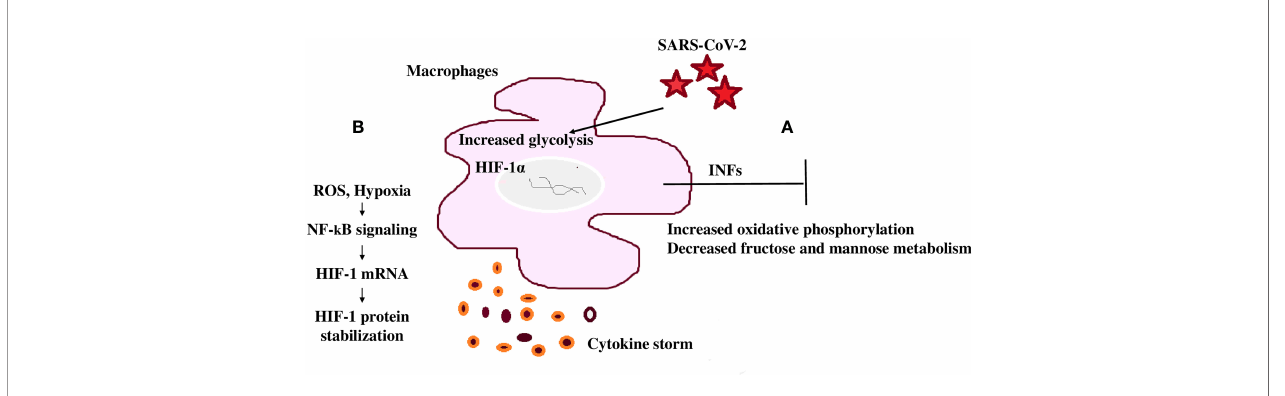
FIGURE 4 | SARS-CoV-2 mediated immunomodulation contribution to mortality (A) COVID-19 patients share a common immunomodulatory failure to induce signi fi cant type I IFN responses in whole blood or PBMCs. This happens in concurrence with other modulated metabolic pathways including the upregulation of oxidative phosphorylation and downregulation of mannose and fructose metabolism. (B) SARS-CoV-2 spike protein induces monocytes and macrophages and increases glycolytic metabolism associated with the production of in fl ammatory cytokines. This response is dependent on hypoxia-inducible factor-1 a (HIF-1 a ); SARS-CoV-2 infection triggers mitochondrial ROS production that stabilizes HIF-1 a and consequently, activates glycolysis. HIF-1 a -induced changes in monocyte metabolism directly inhibit T cell response that causes progression to epithelial cell COVID-19